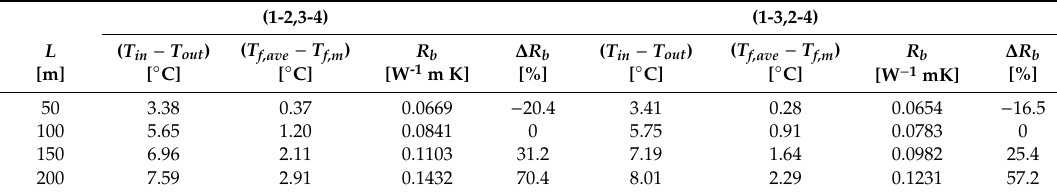
Table 7. Sensitivity of the thermal resistance and fluid temperature to borehole length